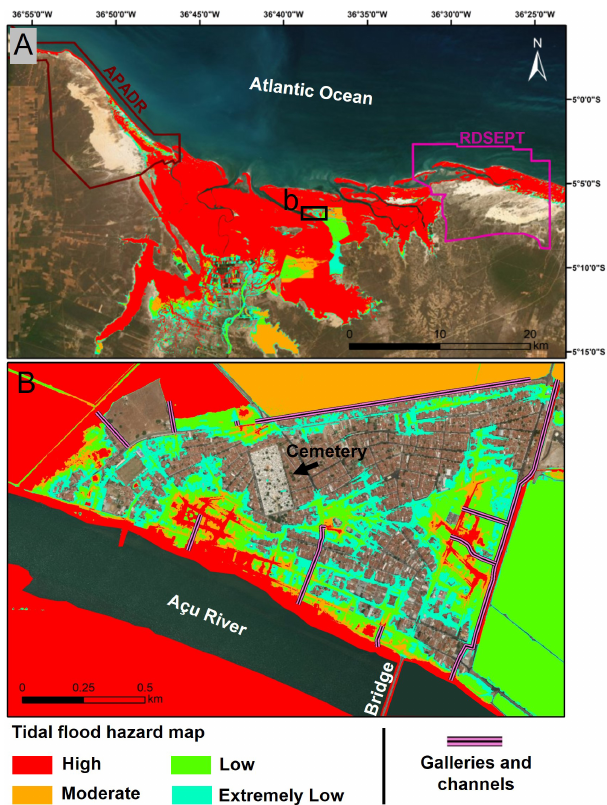
Figure 6. Tidal flood hazard map: (a) total area under study and (b) detail in Macau urban area. Basemap from ArcGIS Online: © ESRI.